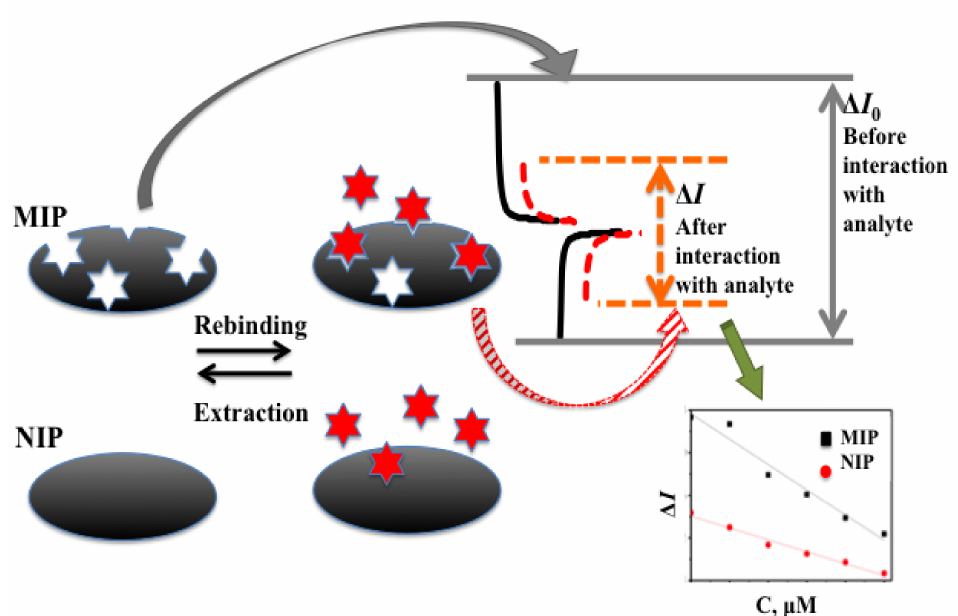
Figure 4. The principle of operation of molecularly imprinted and non-imprinted polymer-based